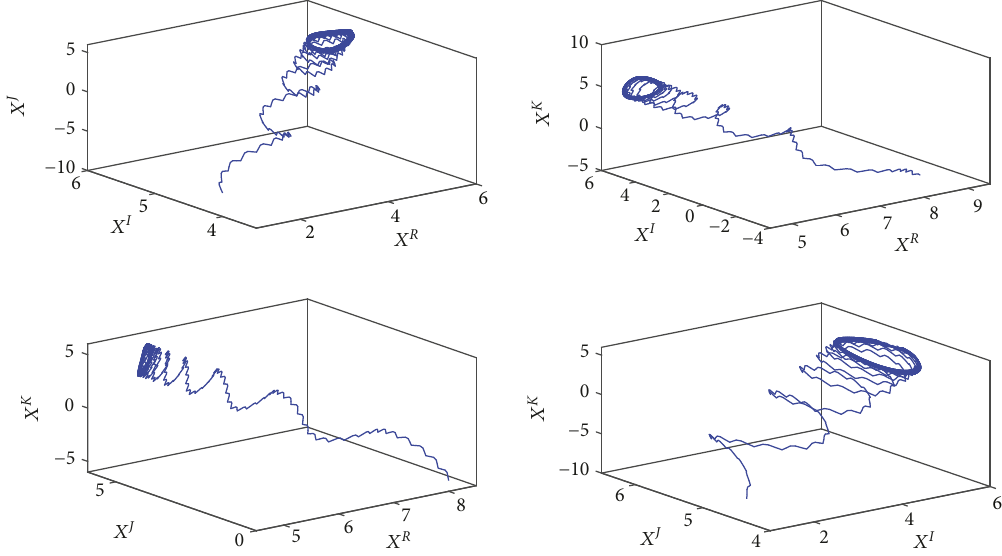
Figure 2: Curves of x in 3-dimensional space for stable